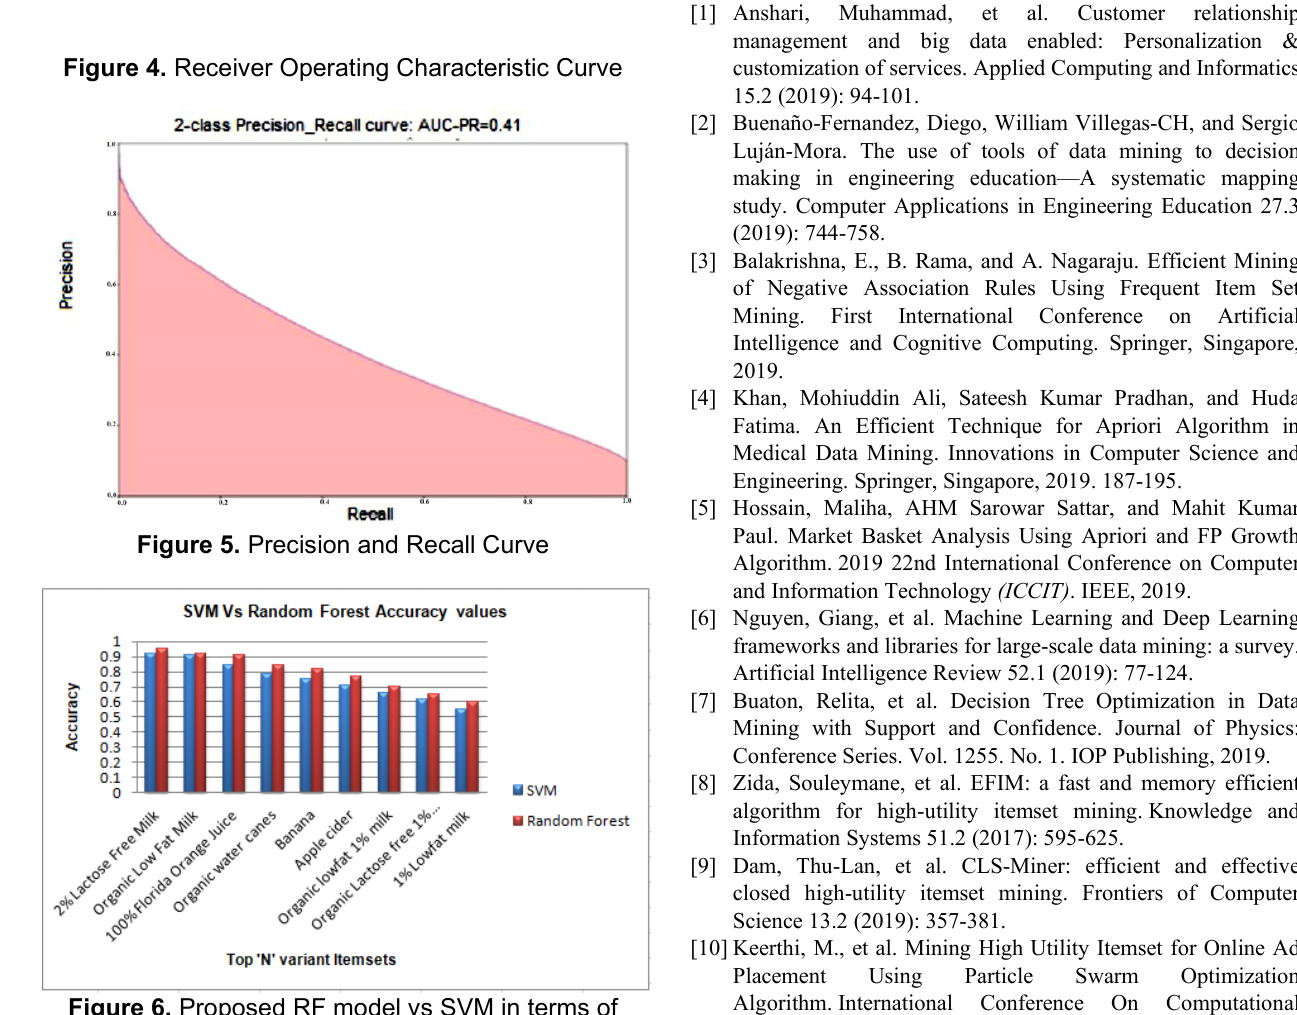
Fi gure 6. Proposed RF model vs SVM in terms of